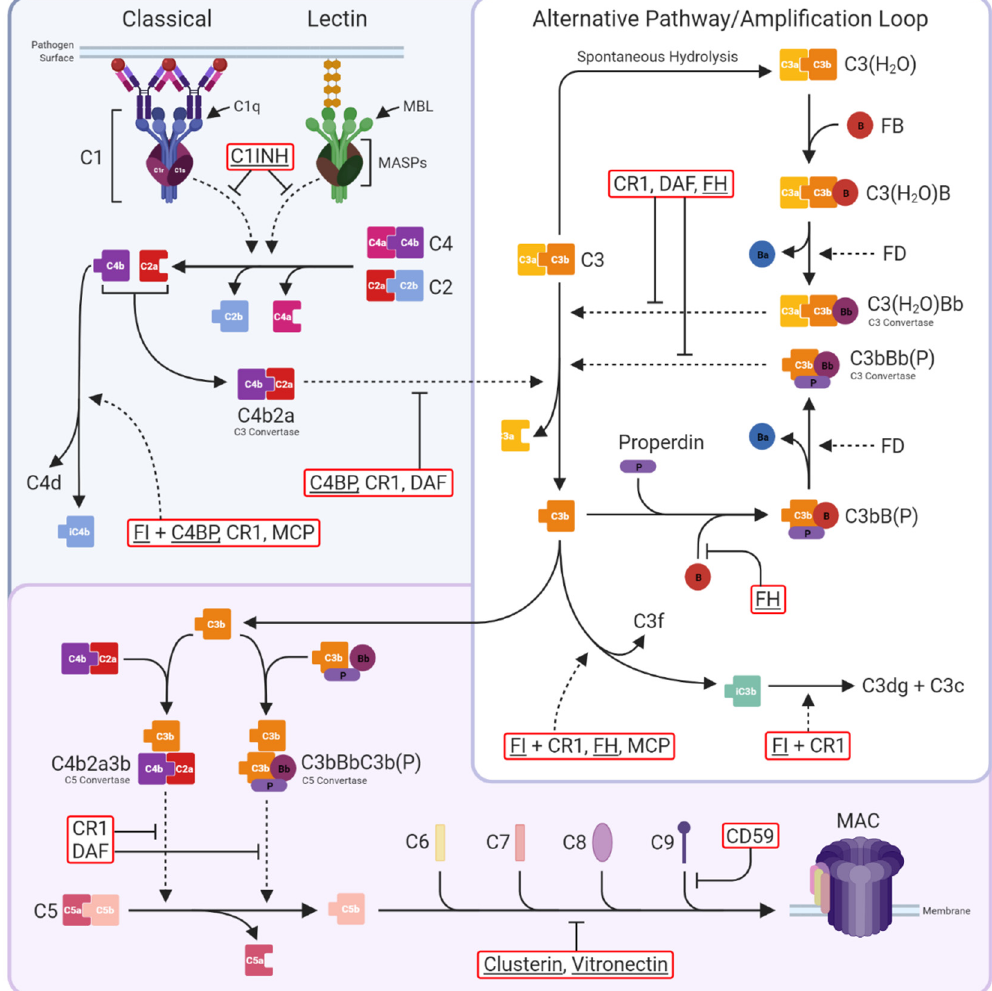
Figure 1. The complement system. Three activation pathways converge on the central C3 molecule. The classical pathway is triggered by binding of antibody-antigen complexes to C1 via C1q subunits. C1r proteolytically activates C1s, which in turn cleaves C4 and C2 to form the classical C3 convertase C4b2a. The lectin pathway begins with recognition of pathogen surface carbohydrates by mannose-binding lectin (MBL) followed by activation of MBL-associated serine proteases (MASPs), which also cleave C4 and C2 to generate C4b2a. The alternative pathway is an amplification loop initiated by C3b generated in the above activation pathways or by spontaneous hydrolysis of C3 to C3(H 2 O). Factor B (FB) then binds C3b/C3(H 2 O), enabling its cleavage by Factor D (FD) to form the alternative pathway C3 convertase C3bBb/C3(H 2 O)Bb; binding of properdin (P) stabilises the convertase. Both C3 convertases cleave C3 into C3a and C3b. The classical and lectin pathways are negatively regulated by C1-inhibitor (C1INH), which inhibits both C1s and MASPs, while the C3 convertases are regulated by C4b-binding protein (C4BP; specific for C4b2a), decay-accelerating factor (DAF; specific for C3bBb), complement receptor 1 (CR1), and Factor H (FH), either directly through increasing decay or indirectly by catalysing cleavage of C4b by Factor I (FI). At the next stage of the pathway, C3b is incorporated into the C3 convertases to form the C5 convertases C4b2a3b and C3bBbC3b(P). These are regulated in the same manner as the C3 convertases and cleave C5 into C5a and C5b to trigger the terminal pathway. C5b is sequentially bound by C6, C7, C8, and up to 18 C9 molecules to form the membrane attack complex (MAC); MAC assembly is inhibited by clusterin and vitronectin in the fluid phase and CD59 on cells. Complement regulators are in red boxes, fluid-phase regulators are underlined. Solid, dotted, and blunt arrows indicate pathway progression, proteolytic cleavage, and direct inhibition, respectively.